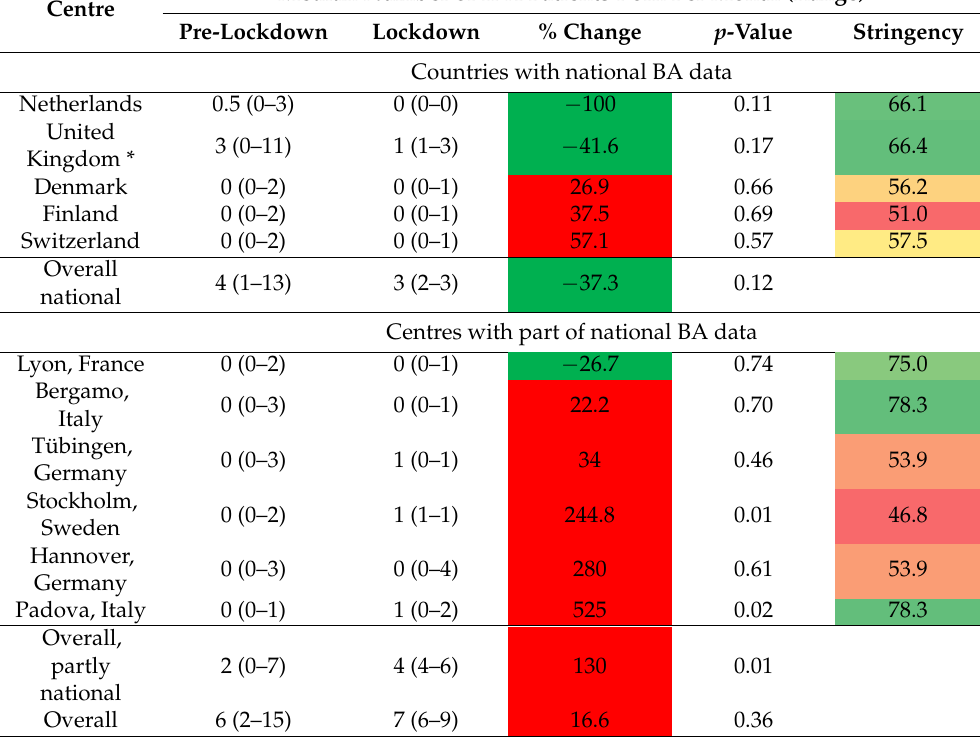
Table 2. Median number of IBA patients born per month per participating centre or country (national BA